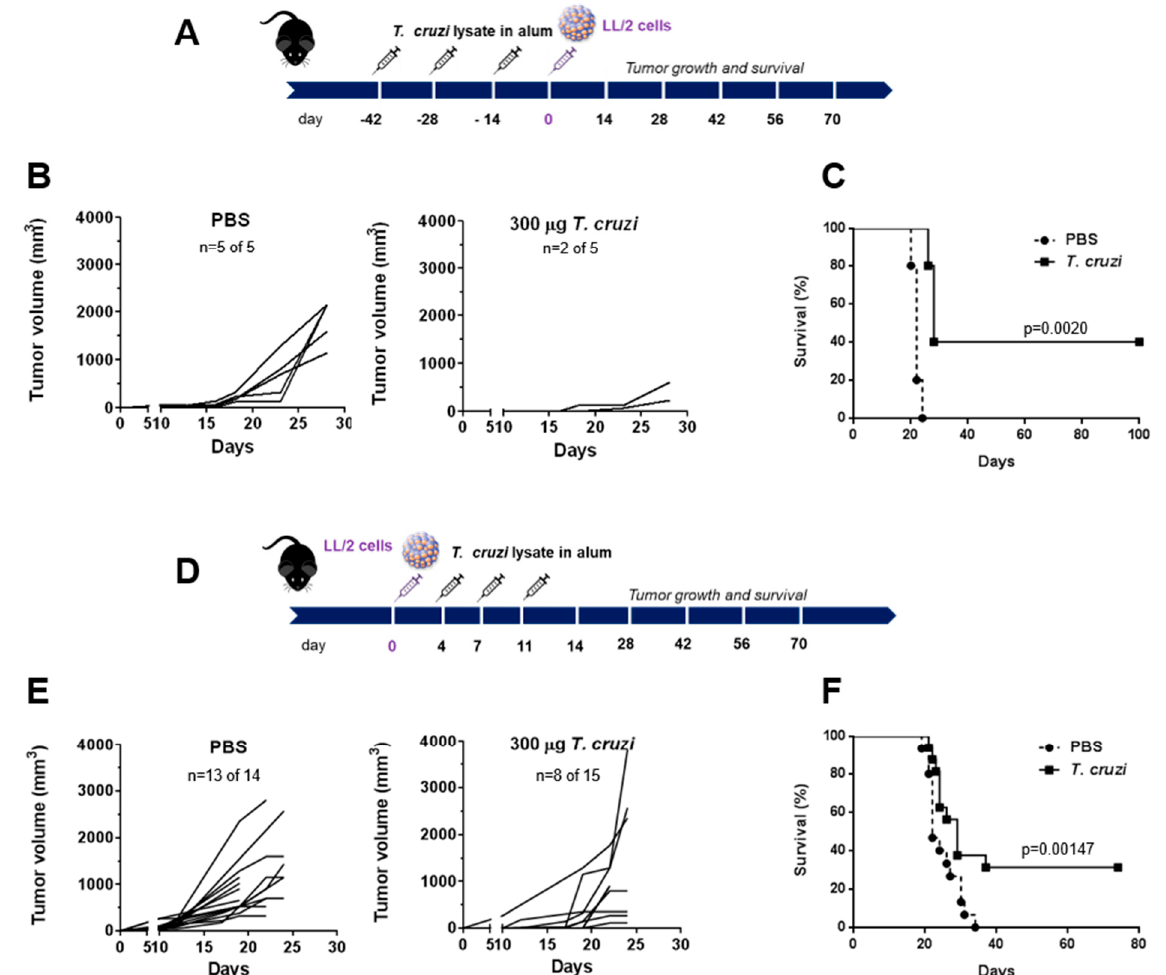
Figure 1. Immunisation with T. cruzi epimastigote lysate protects against LL/2 tumour growth in both prophylactic and therapeutic settings: ( A ) C57BL/6 mice were pre-treated three times in two- week intervals with T. cruzi (300 µg/mouse) or PBS in aluminium hydroxide (alum) before LL/2 cell s.c. challenge (100,000 cells/mouse). ( B ) Tumour growth was measured regularly using a calliper in mice that developed tumours; “n” represents the number of mice that developed tumours out of the total mouse number used in the experiment. ( C ) Survival of T. cruzi -pre-treated and control mice was followed for 100 days after tumour challenge. ( D ) After s.c. administration of LL/2 cells (day 0, 100,000 cells/mouse), C57BL/6 mice received T. cruzi (300 µg/mouse) or PBS in alum on days 4, 7, and 11. ( E ) Tumour growth was measured regularly using a calliper in treated and control mice. ( F ) Survival of T. cruzi -treated and control mice was followed for 80 days after tumour challenge. Rep- resentative results from three independent experiments are shown.